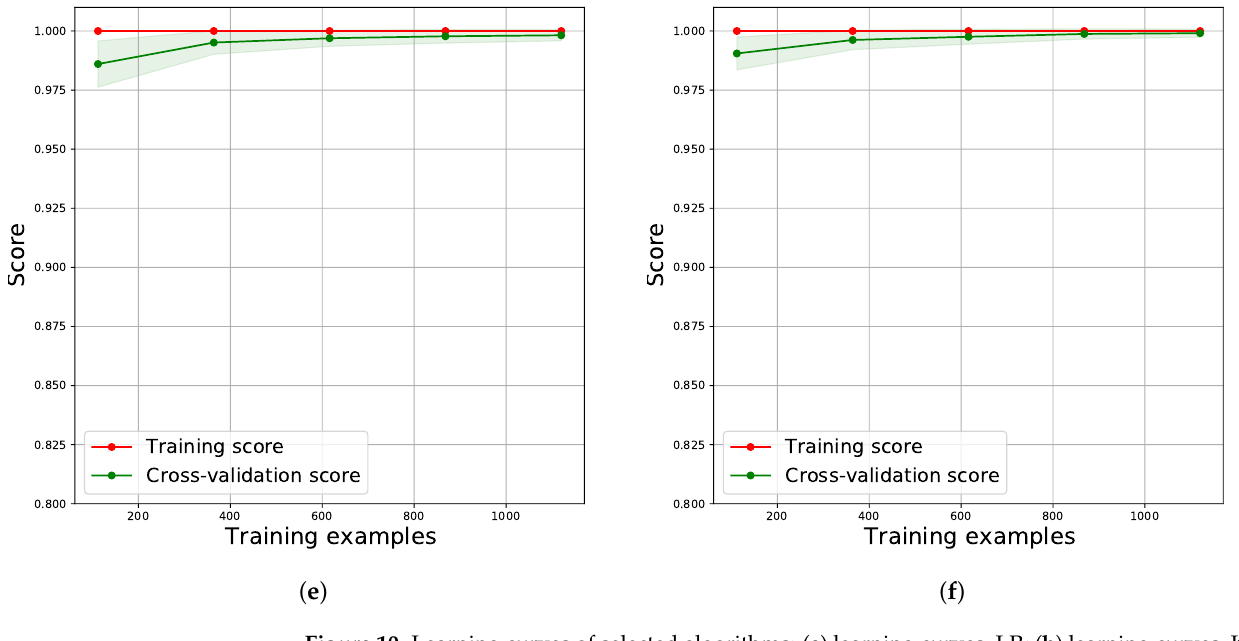
Figure 10. Learning curves of selected algorithms: ( a ) learning curves_LR; ( b ) learning curves_KNN; ( c ) learning curves_SVM; ( d ) learning curves_NB; ( e ) learning curves_DT; ( f ) learning